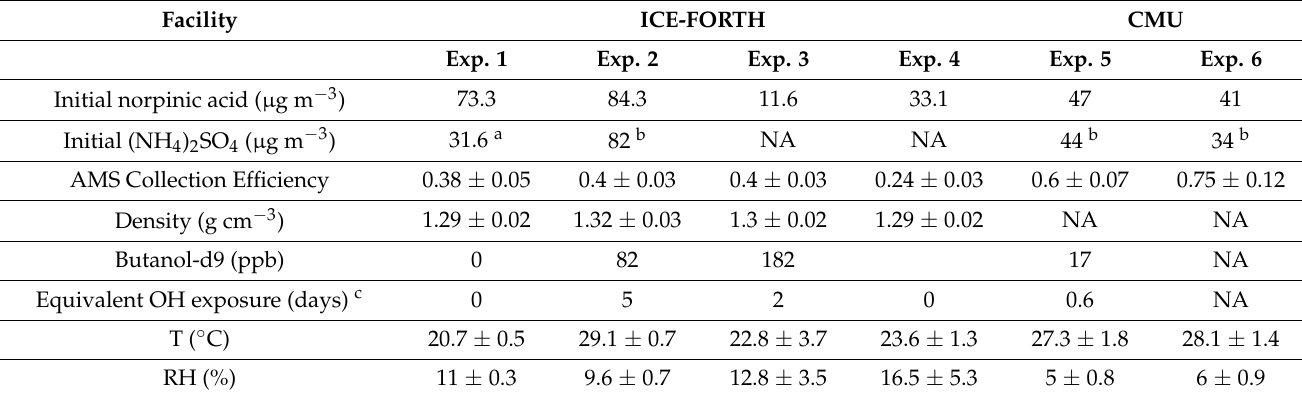
Table 1. Experimental parameters. Experiments 1–4 were conducted in the ICE-HT chamber, while experiments 5 and 6 took place in the CMU